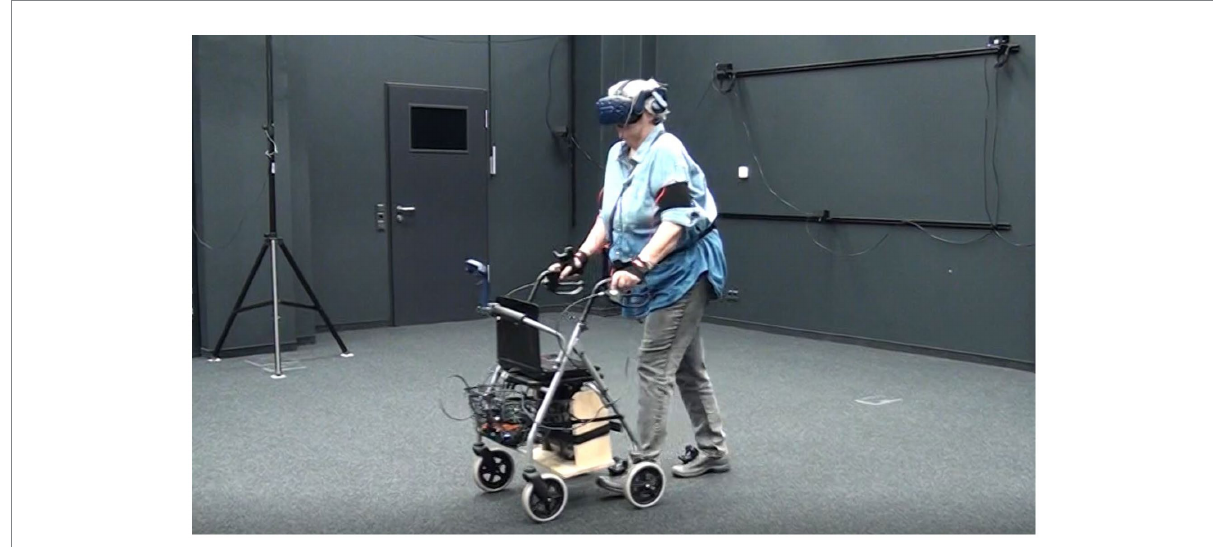
FIGURE 1 A participant wearing the HTC VIVE and using the walking frame during the VR